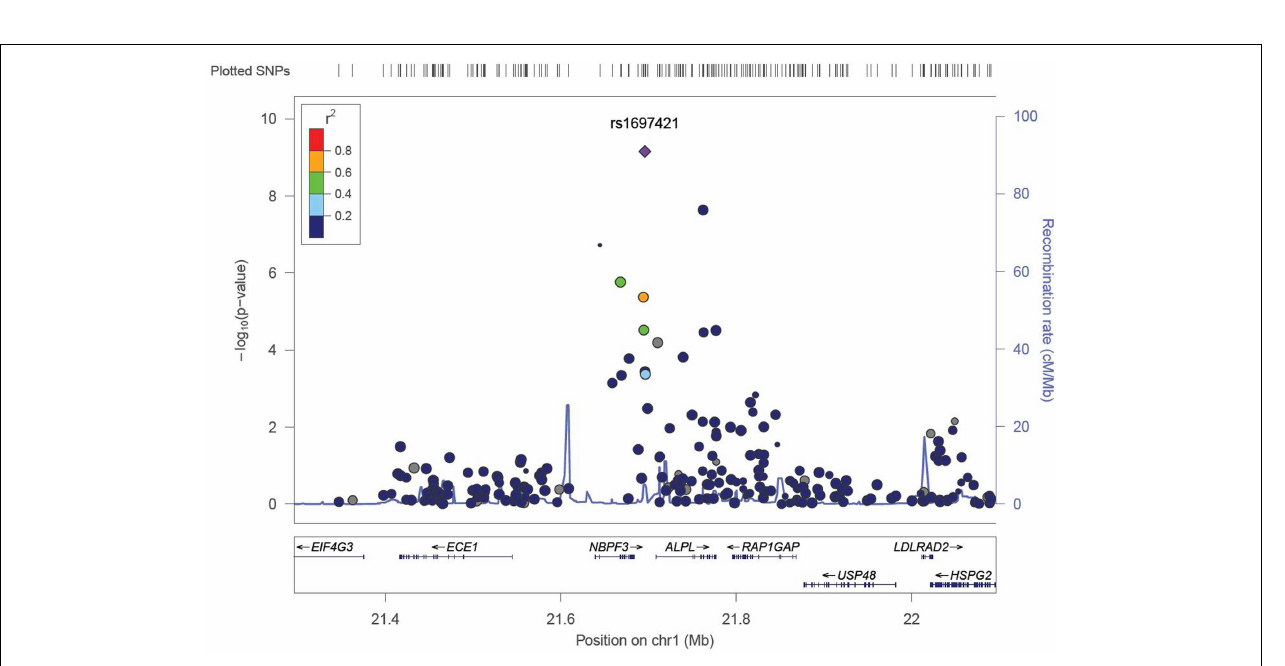
FIGURE 3 | LocusZoom association plot for single SNP associations withVitamin B 6 at the ALPL locus .The SNP position and -LOG ( P -value) are plotted on the X and Y axis, respectively.